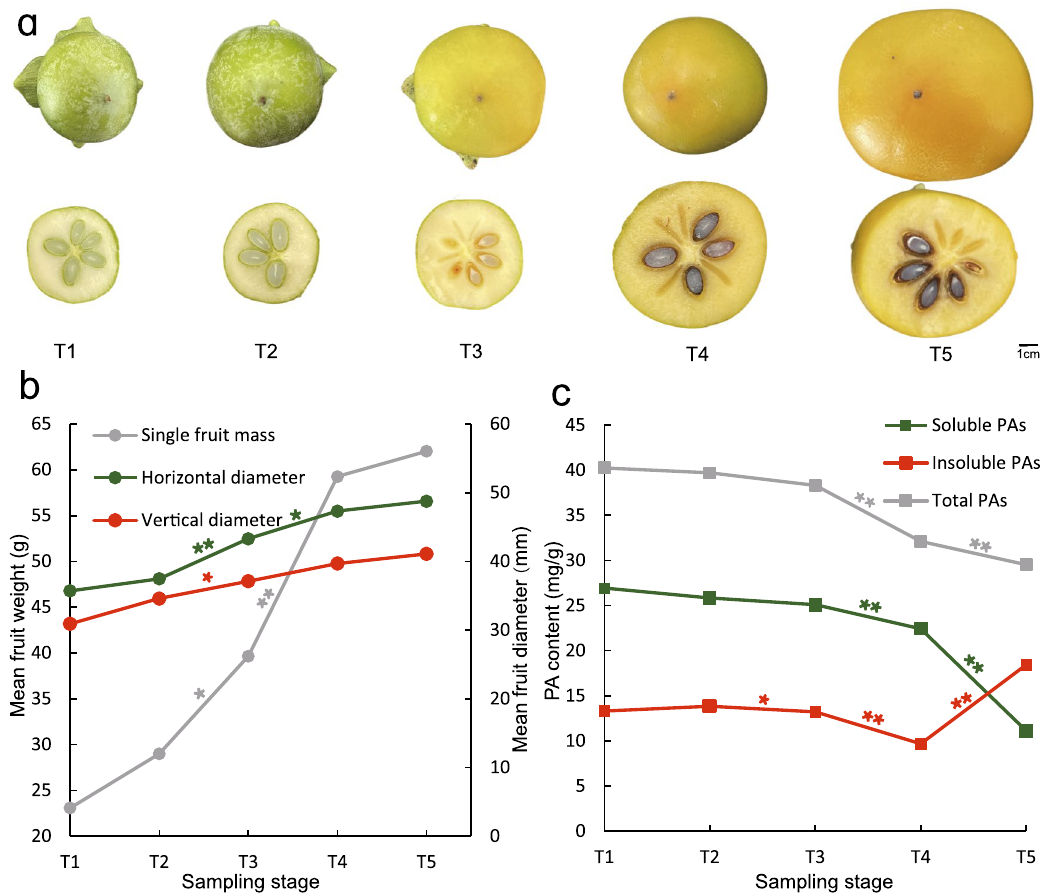
Figure 1. Five developmental stages of C-PCNA persimmon ‘Xiaoguo-tianshi’. ( a ) Fruit morphology. ( b ) Mean fruit weight and diameter. ( c ) Soluble PAs, insoluble PAs, and total PA content. Values are the means of four replicates. **Indicates a significant difference at P < 0.01. * indicates a significant difference at P <